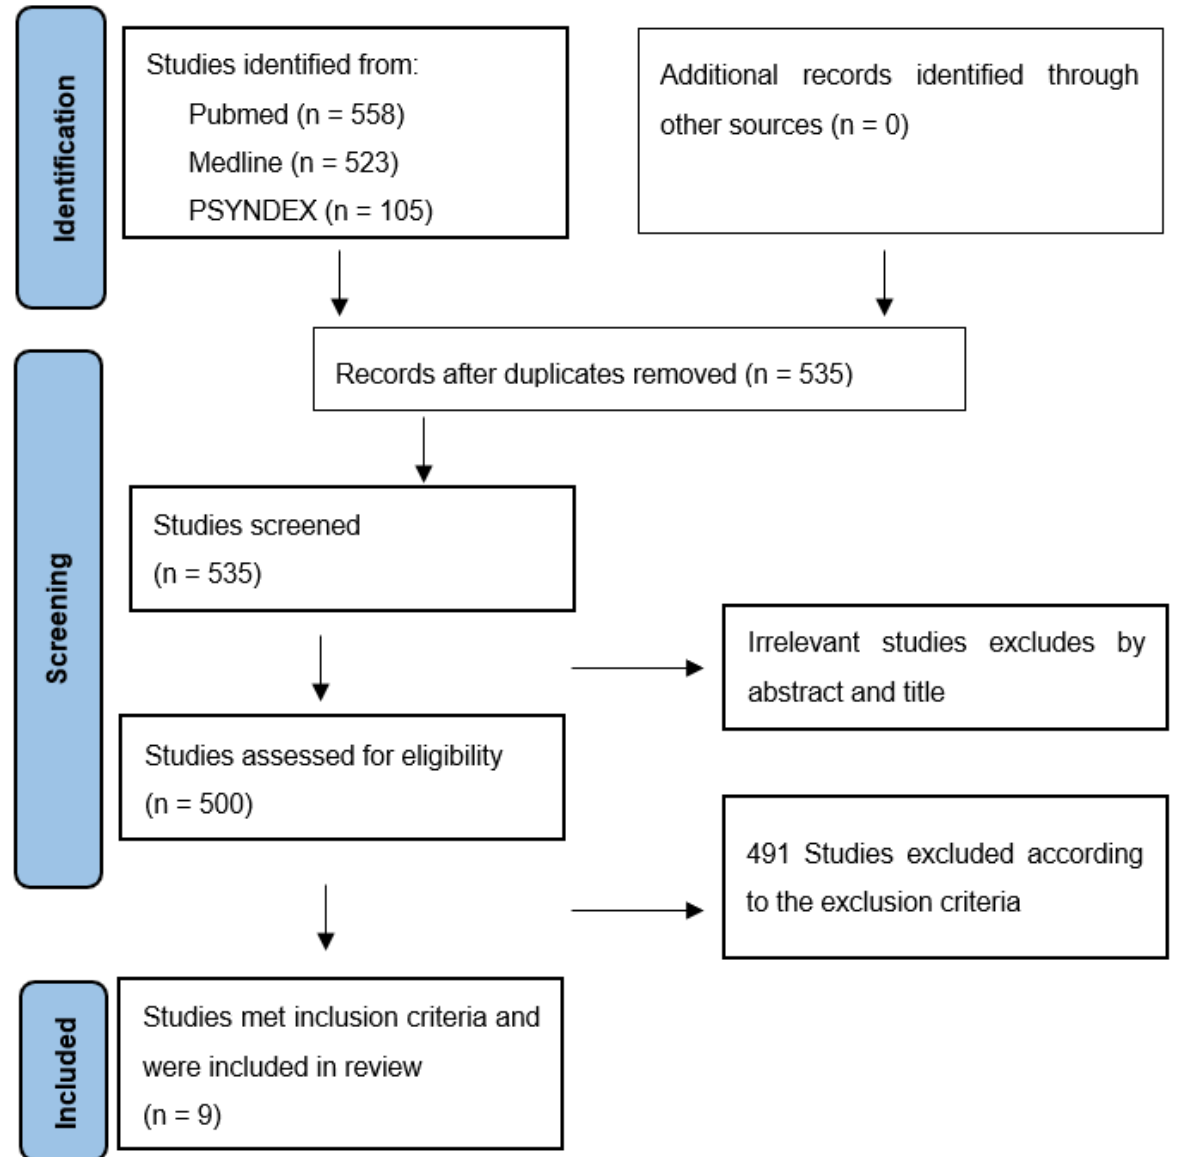
Figure 1. PRISMA flow chart article disposition.